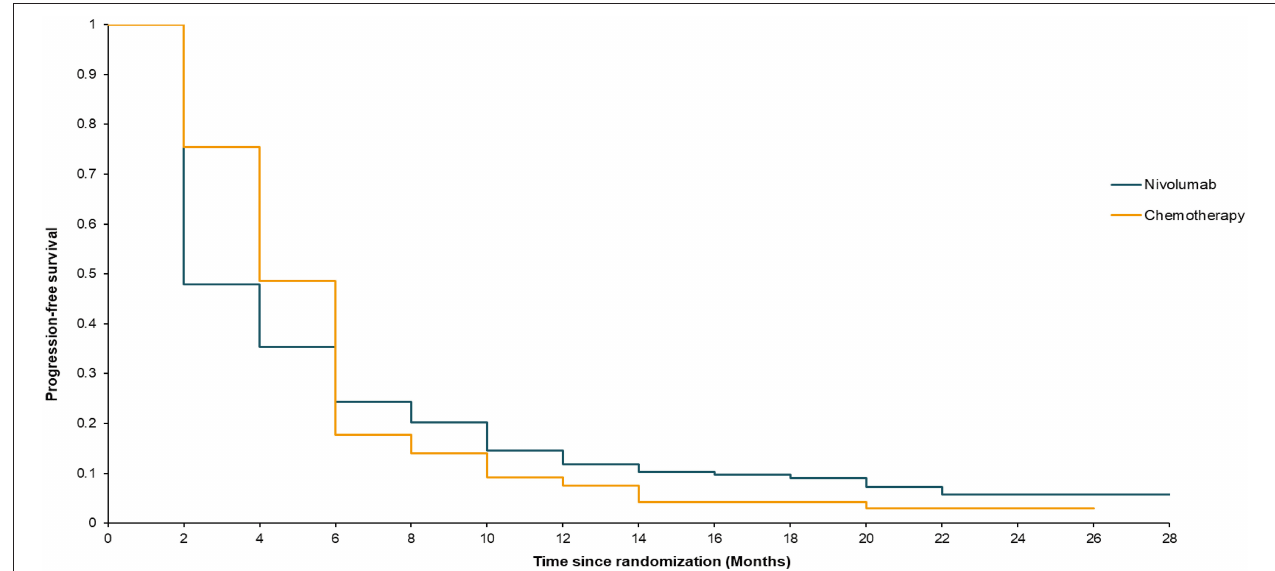
FIGURE 3 | Estimated progression survival curve for the ATTRACTION-3 trial.